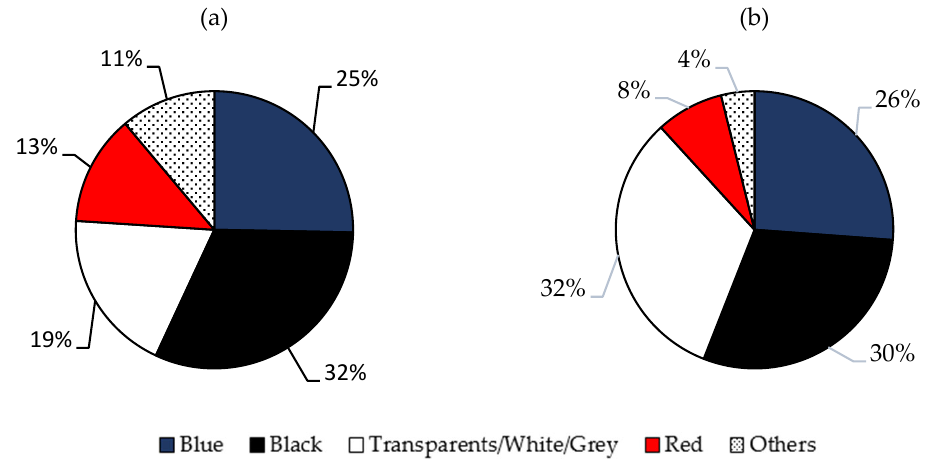
Figure 3. Most abundant colors in MFs present in the literature data from the Mediterranean Sea, both in the biota ( a ), and in seabed and seawater samples ( b ).